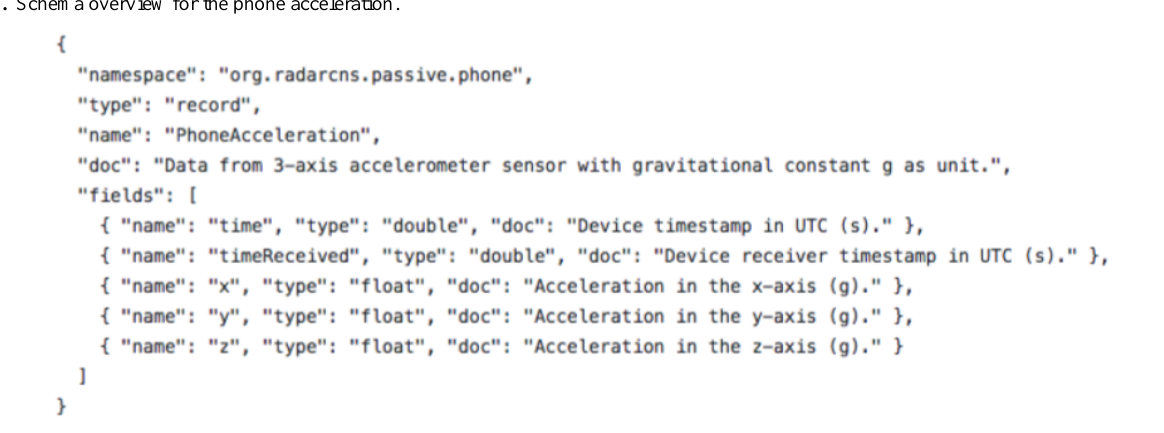
Figure 3. Schema overview for the phone acceleration.